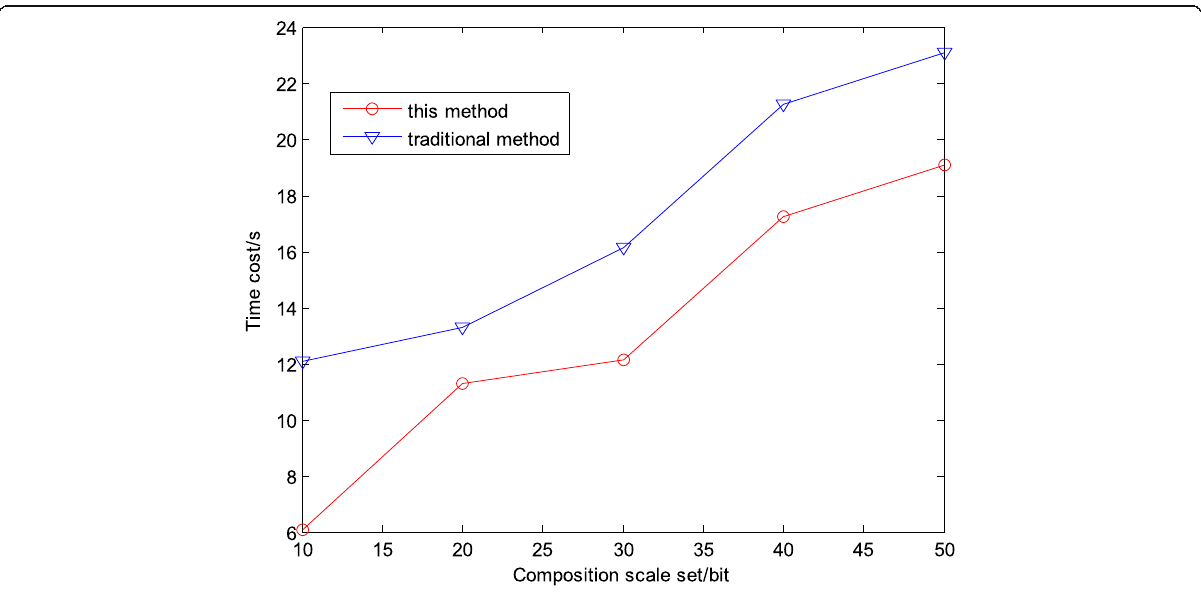
Fig. 4 Comparison of time cost for data